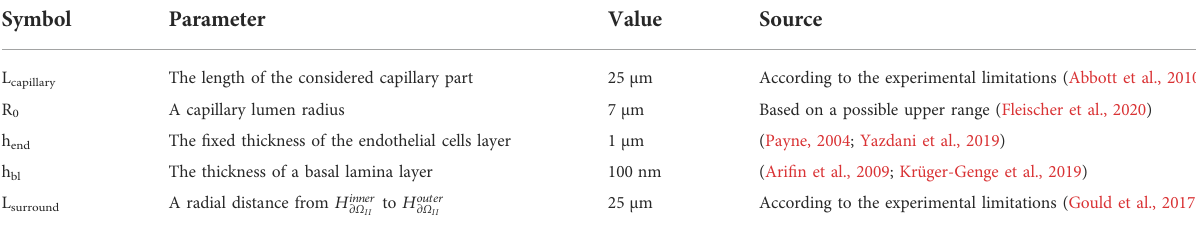
TABLE 1 The geometrical parameters of a NVU virtual phantom used for the modelling.